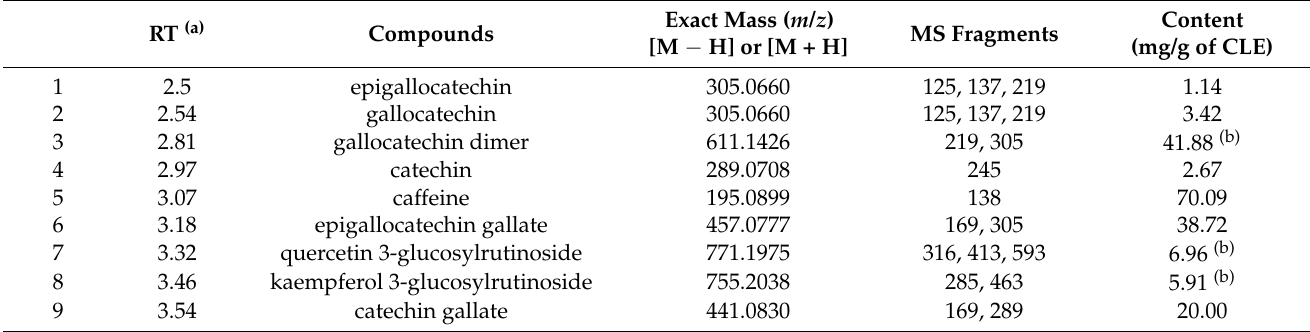
Table 1. Identification of major compounds from CLE using UPLC-Q-TOF MS with MRM mode and their